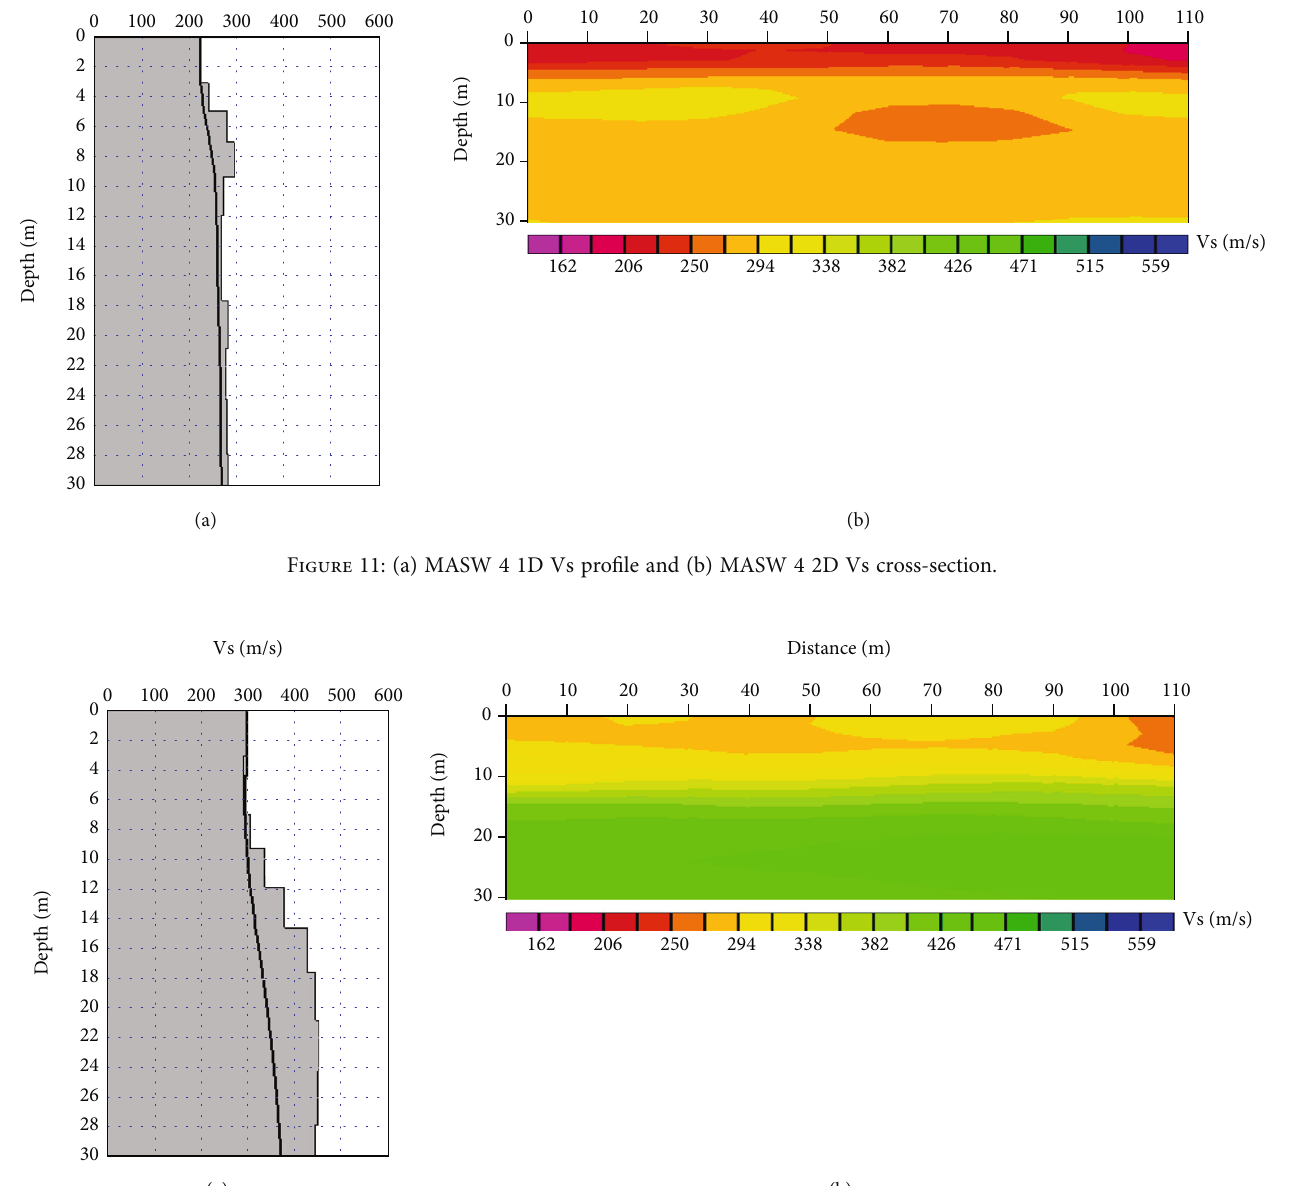
Figure 12: (a) MASW 5 1D Vs pro fi le and (b) MASW 5 2D Vs cross-section.